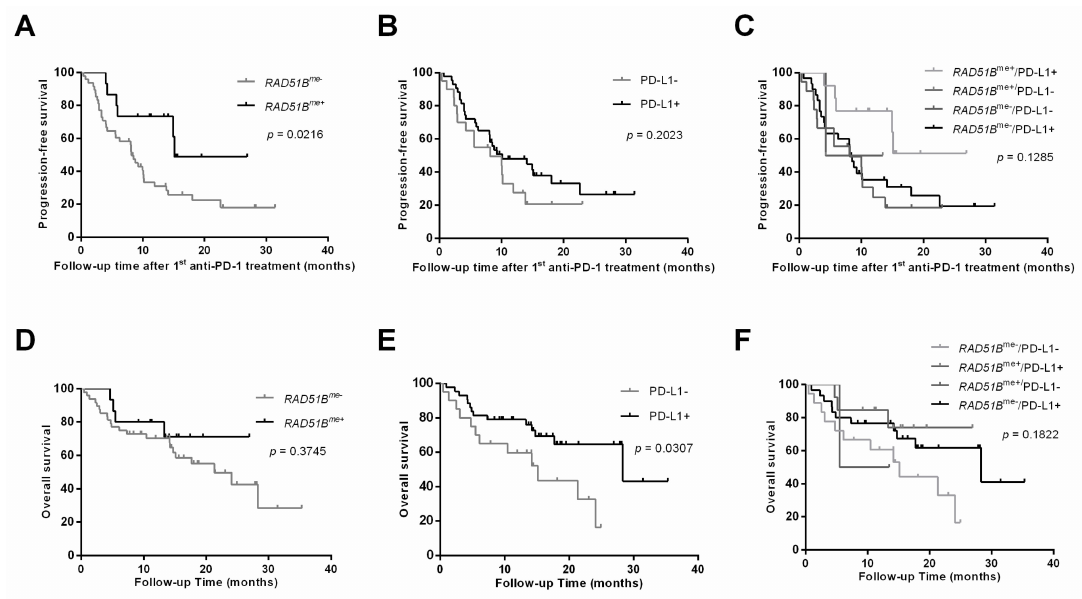
Figure 3. Kaplan–Meier survival curves for progression-free survival (after first anti-PD-1 treatment) of patients according to ( A ) RAD51B me status; ( B ) PD-L1 status; and ( C ) combined RAD51B me and PD-L1 status. Kaplan–Meier survival curves for patients’ overall survival according to ( D ) RAD51B me status, ( E ) PD-L1 status, and ( F ) combined RAD51B me and PD-L1 status. Log-rank test. RAD51B me was considered positive when promoter methylation levels >